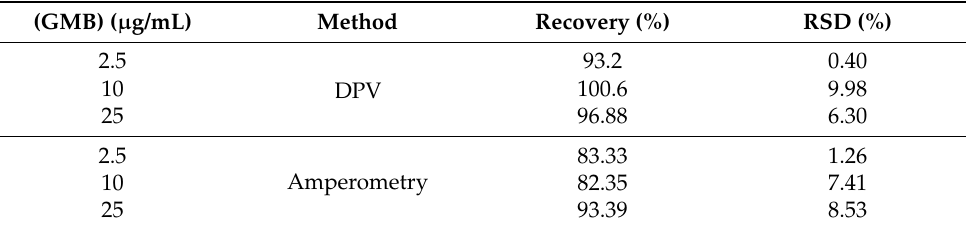
Figure 5. ( a ) DPVs obtained in PBS solution of pH 7.4 (gray) and 10 μg/mL GMB infusion solution (green). ( b ) Chronoamperogram of successive additions of 25, 90 and 140 μL of 500 μg/mL GMB infusion solution in 5 mL PBS (pH 7.4; 0.05 M) corresponding to 2.5, 10 and 25 μg/mL GMB. Table 2 . Results obtained with the electrochemical methods optimized for solutions prepared from GMB powder for the infusion solution .